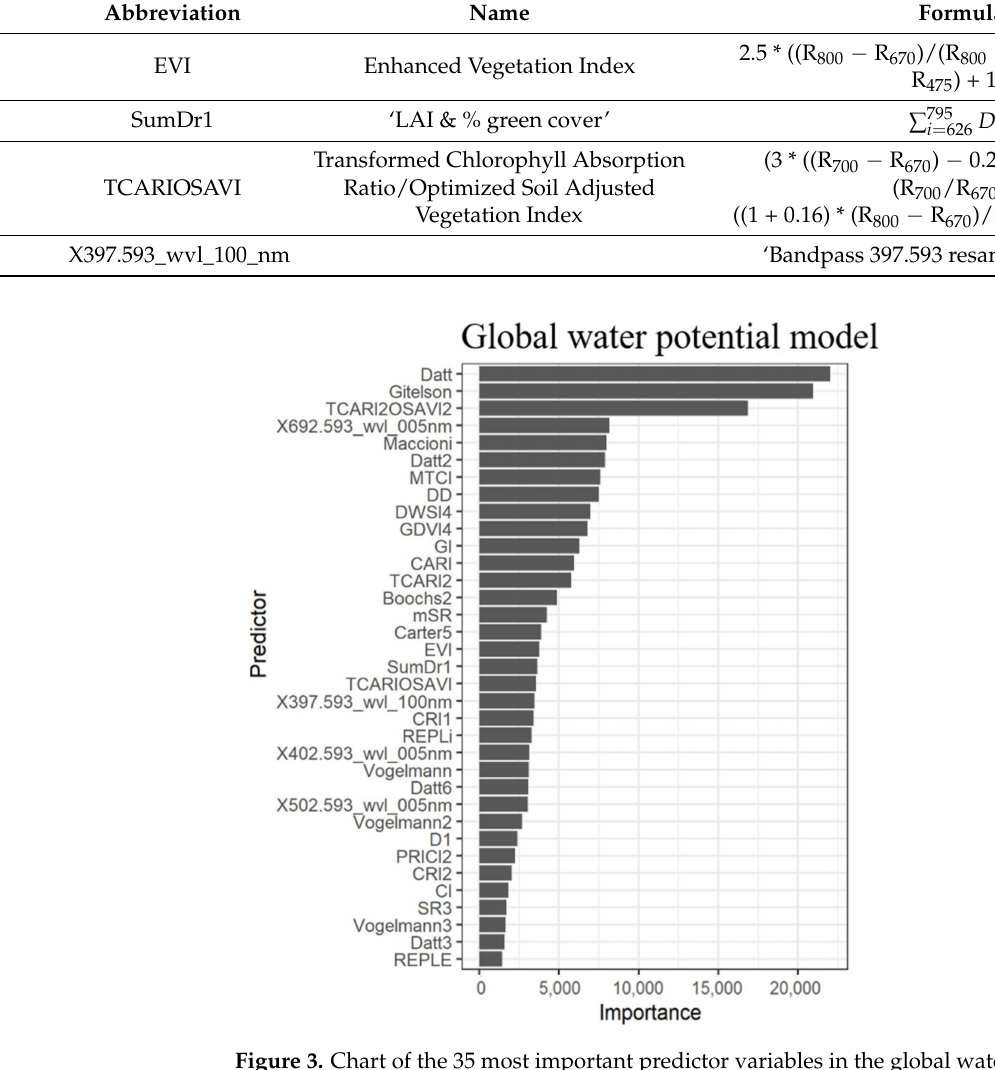
eighth of green fruit. This predictor was the 24th for peak bloom. Green fruit and color bandpass X897.593 resampled at 100 nm. In all three individual models for water potential, MTCI (MERIS Terrestrial Chlorophyll Index) was a high predictor. Medium Resolution Imaging Spectrometer (MERIS) terrestrial chlorophyll index measures chlorophyll in the